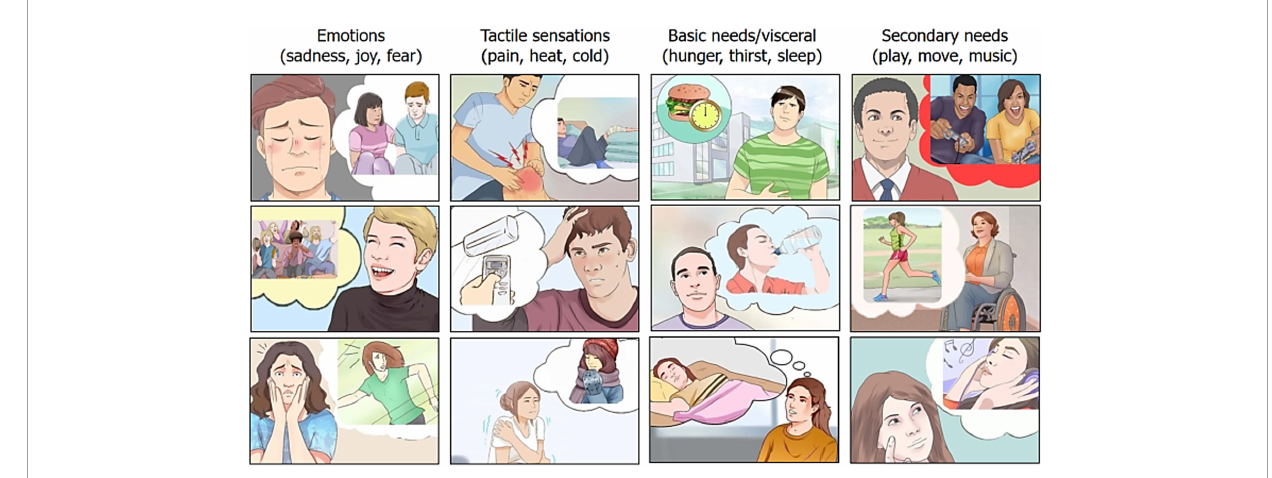
FIGURE1 Example of pictograms related to the 12 motivational states or craves. Taken from the BCI pictionary by Proverbio and Pischedda (2023).